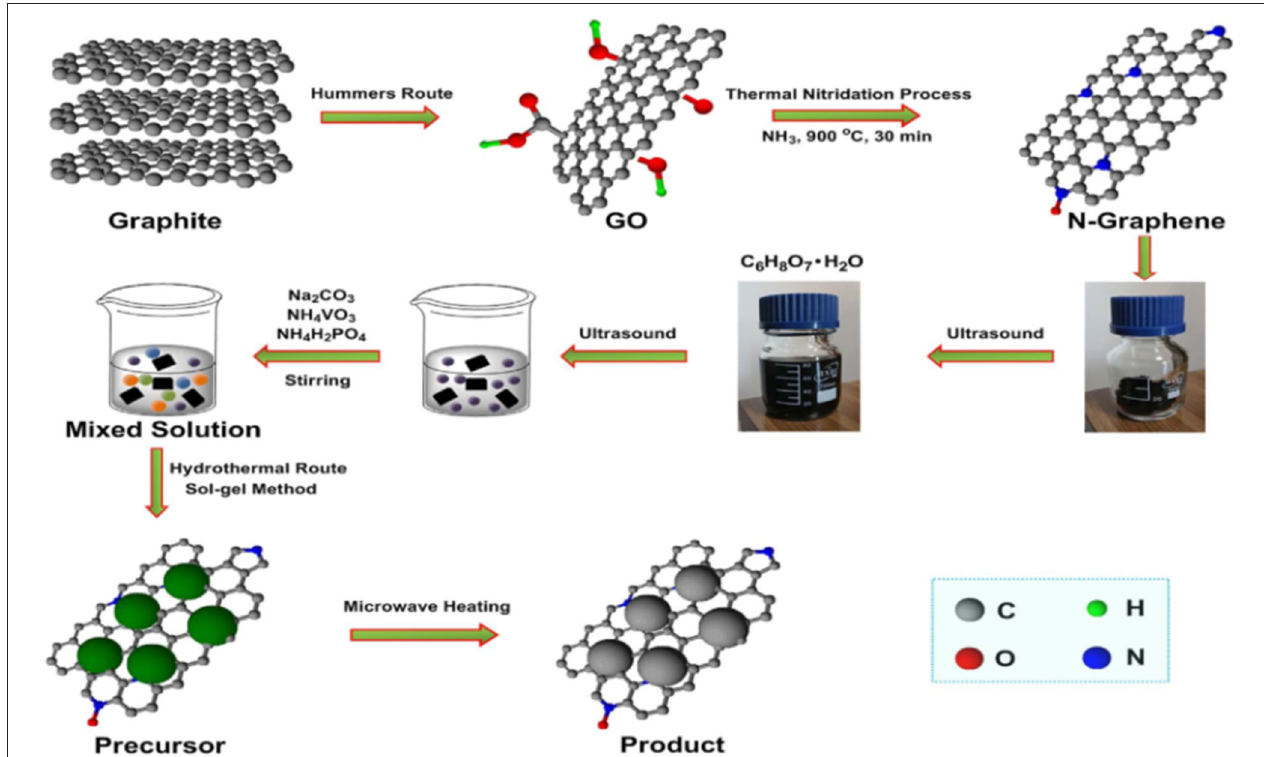
FIGURE 9 | The formation process of the NVP/C@N-graphene composite by schematic diagram.